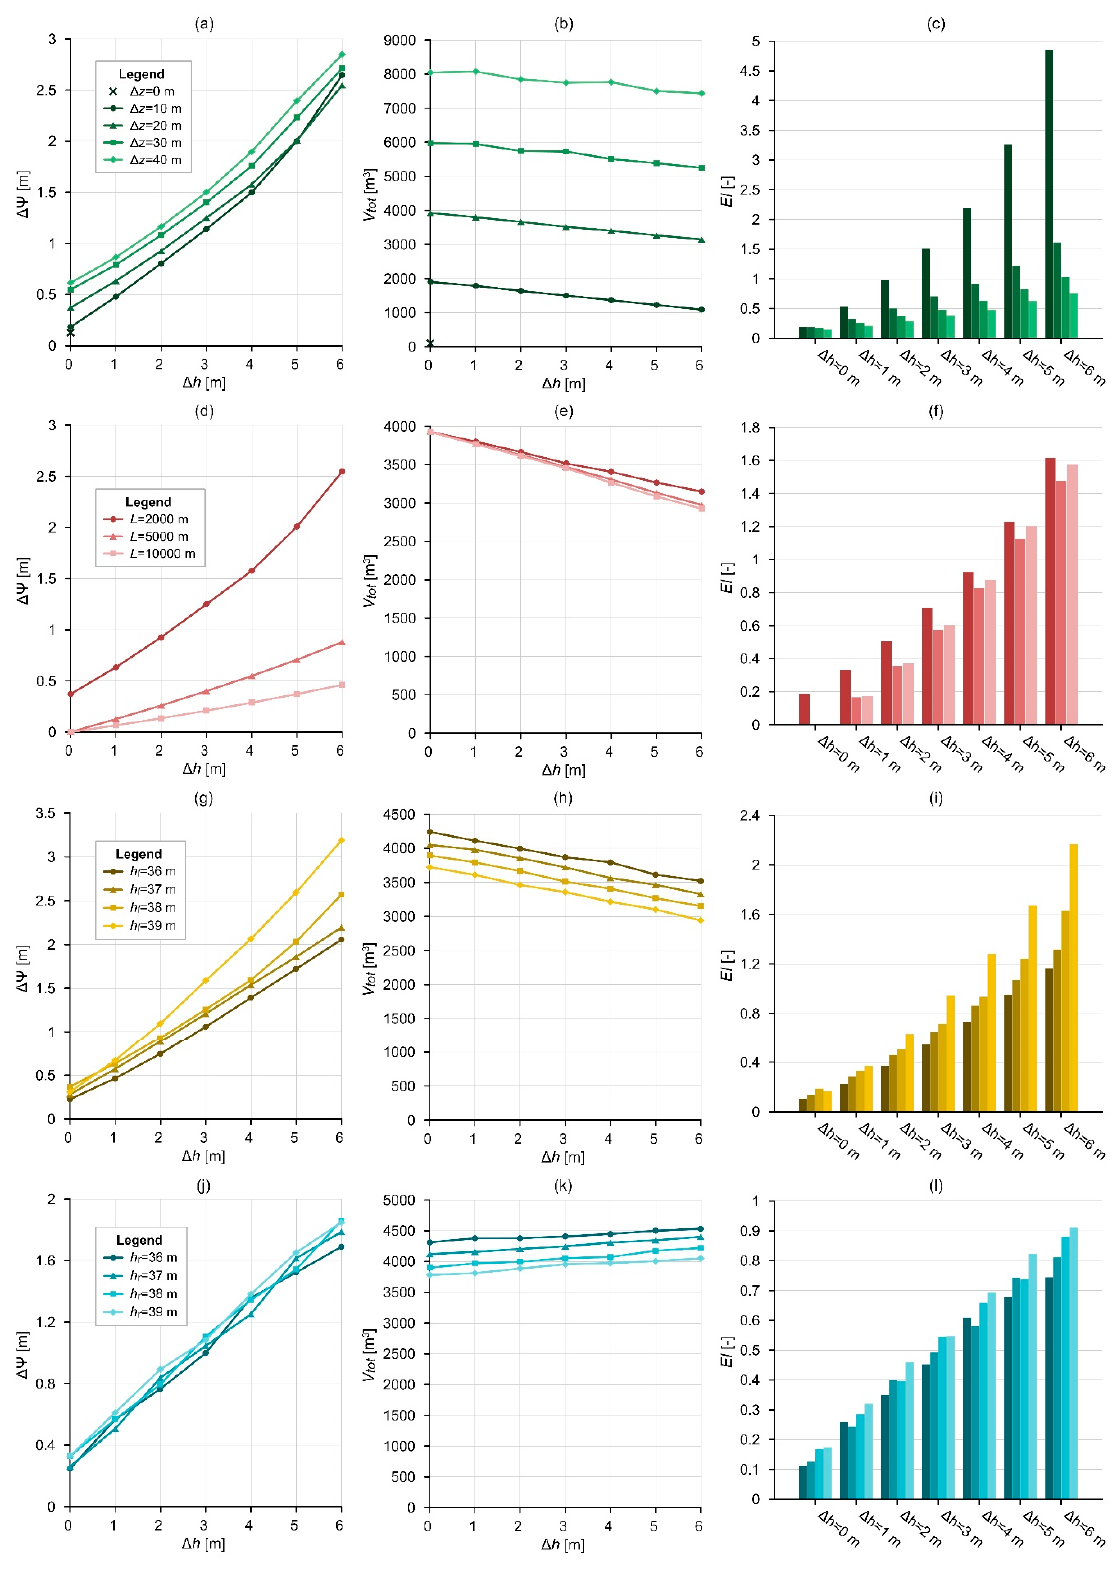
Figure 4. Effect of the topography ( a – c ), the model length ( d – f ) and the elevation of the water table ( g – l ) on the water level increase ΔΨ —( a , d , g , j ), the cumulative volume of infiltrating water V tot —( b , e , h , k ), and the Efficiency Index EI —( c , f , i , l ) after five years (( a – c ): SG ‐ 1; ( d – f ): SG ‐ 2; ( g – i ): SG ‐ 3/A; ( j – l ): SG ‐ 3/B) plotted against the hydraulic head difference ( Δ h ).